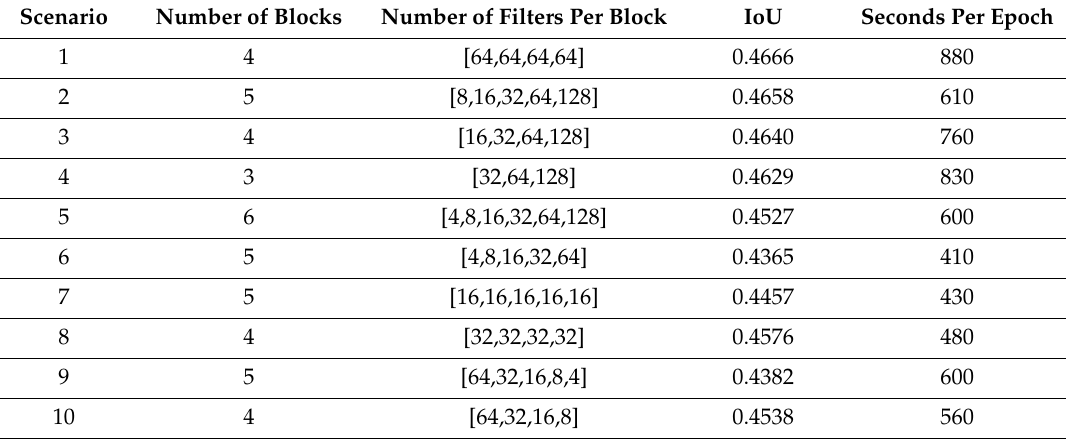
Table 2. Comparison of di ff erent training scenarios regarding the optimal block